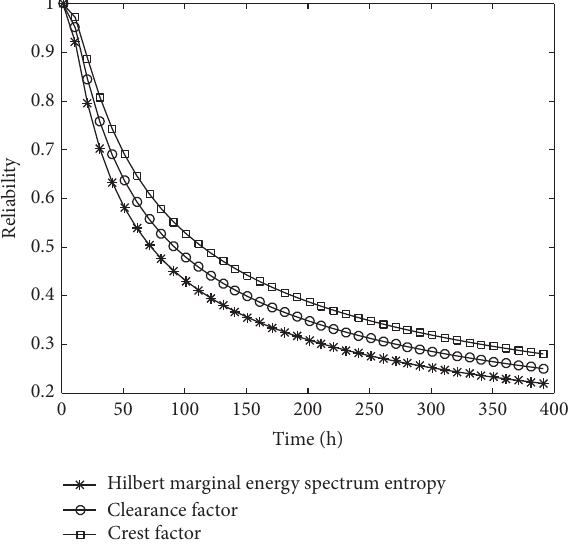
Figure 8: Reliability of three features under normal operating condition.